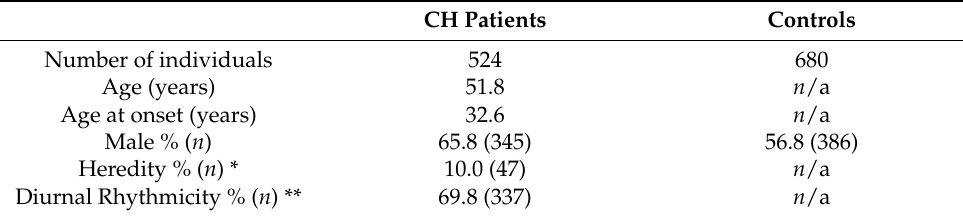
Table 1. Demographic